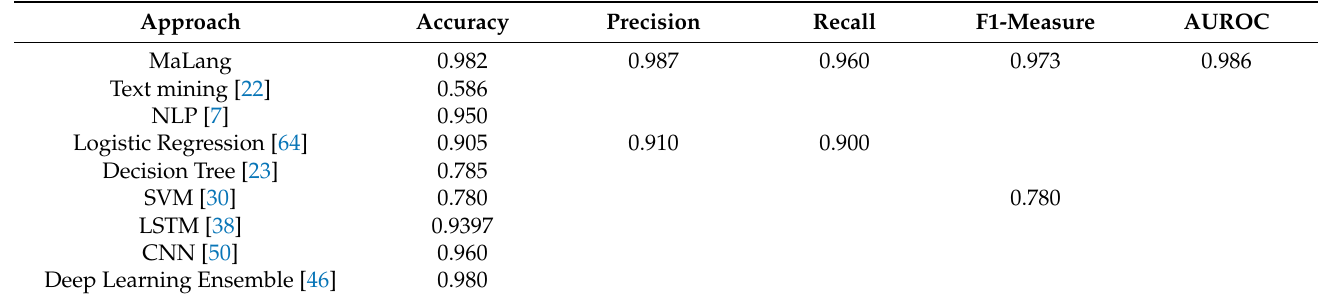
Table 3. Performance comparison of MaLang with respect to existing state-of-the-art detection models.